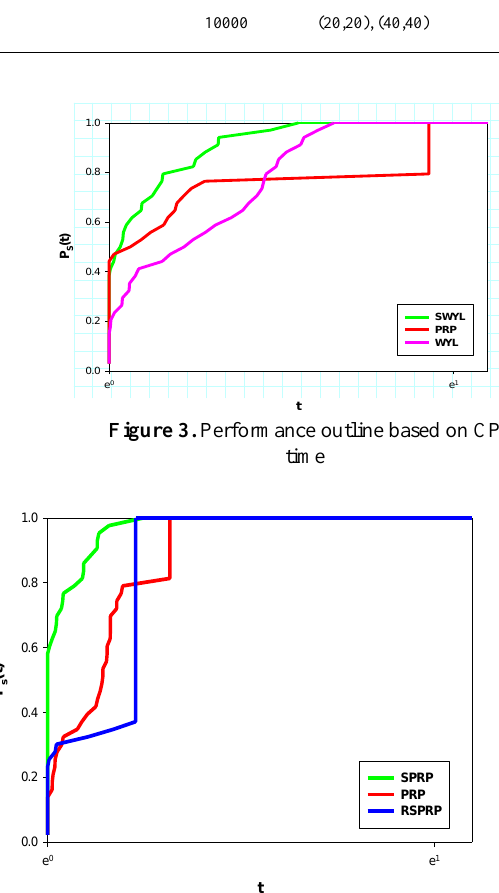
Figure 4. Performance outline based on the number of